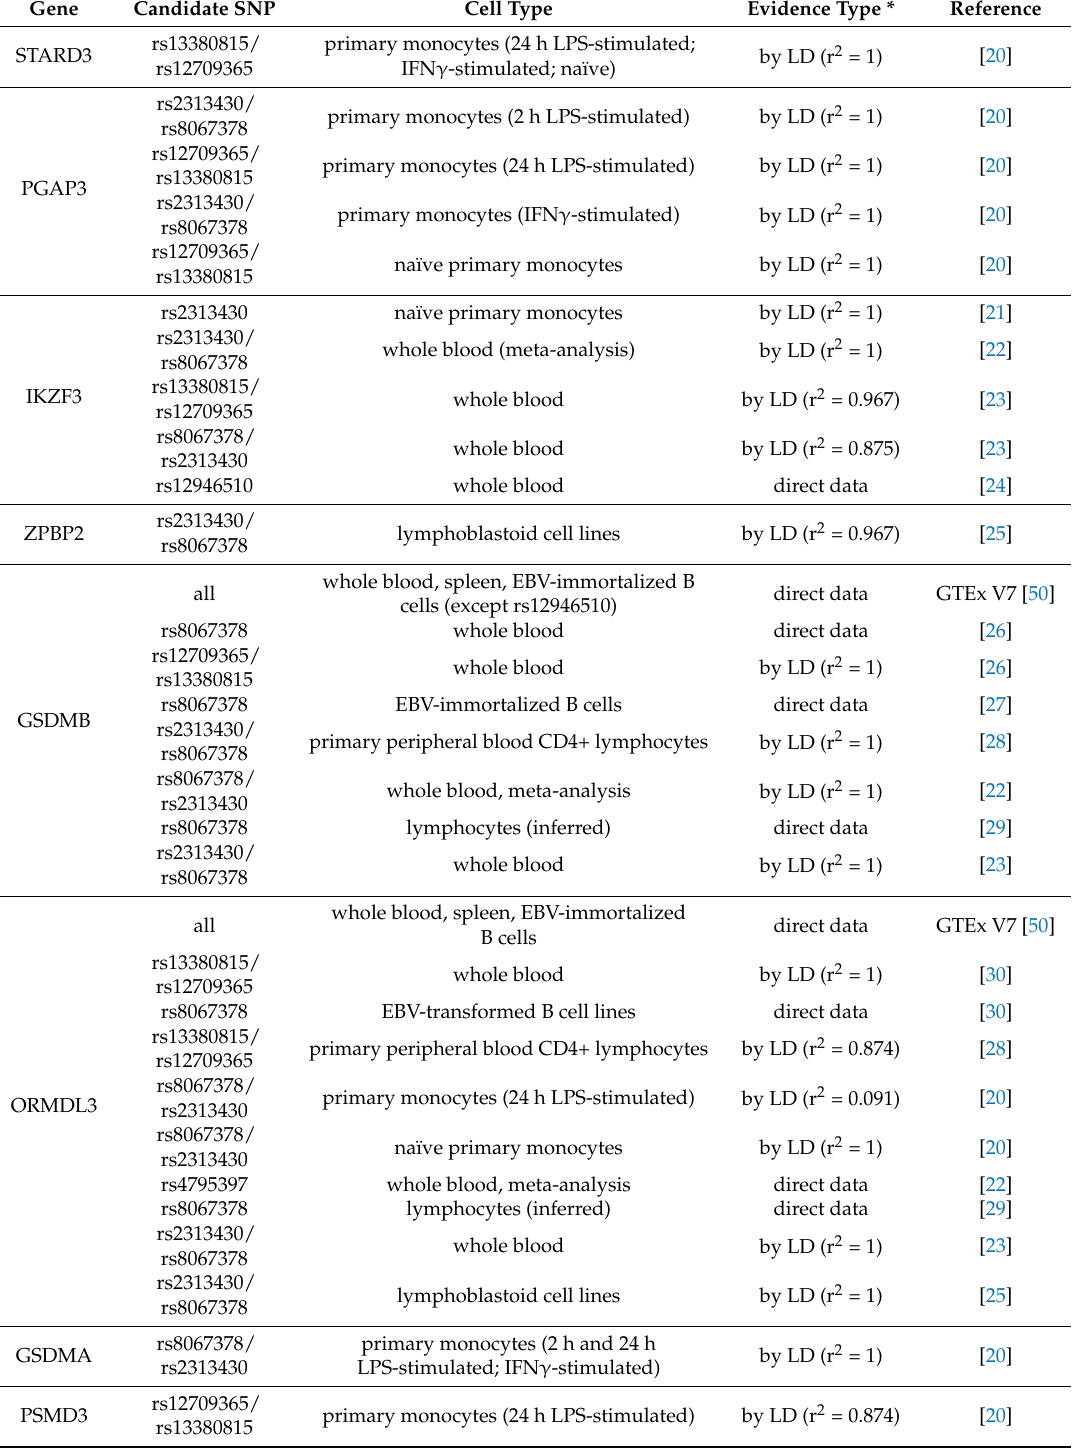
Table 6. Association of studied variants with expression levels of genes located within 100 kb distance from the candidate functional